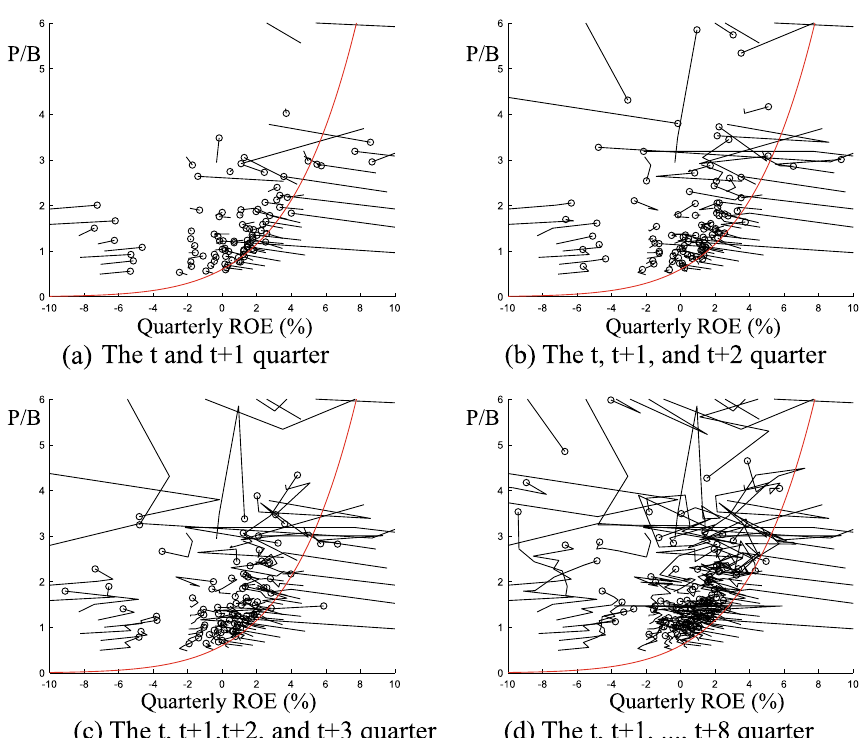
Fig. 15 The movement path of ROE (X axis) and P/B (Y axis) in the current quarter and the subsequent 1, 2, 3, and 8 quarters: Small‑cap